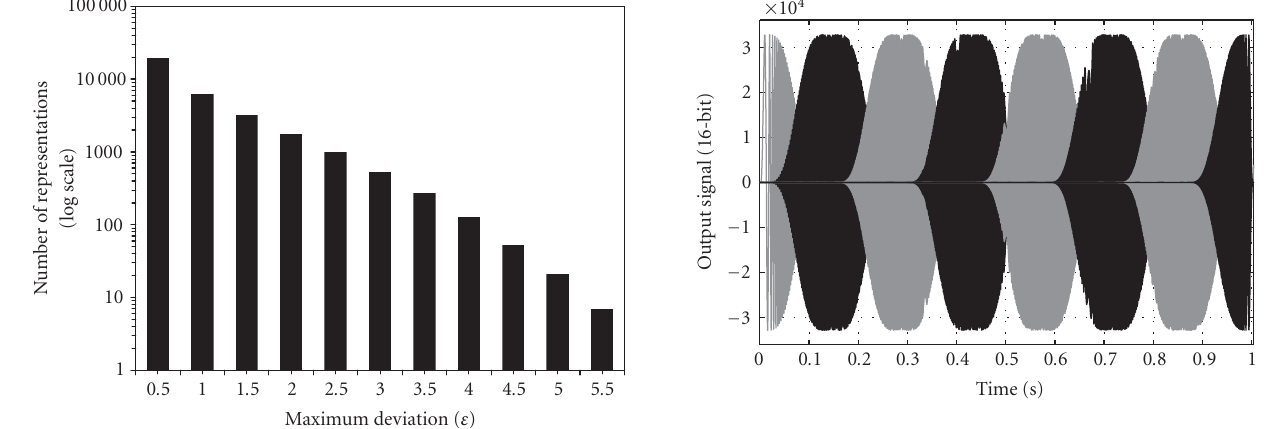
Figure 14: MDLNS filterbank output of an 8kHz chirp